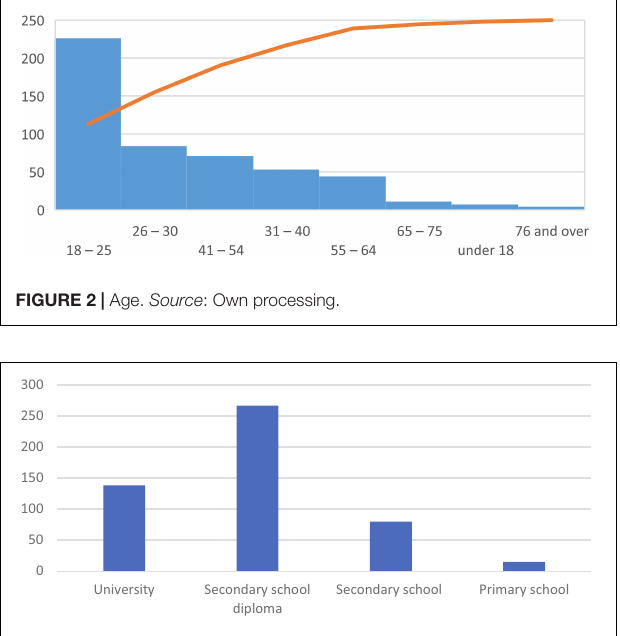
FIGURE 3 | Education. Source : Own